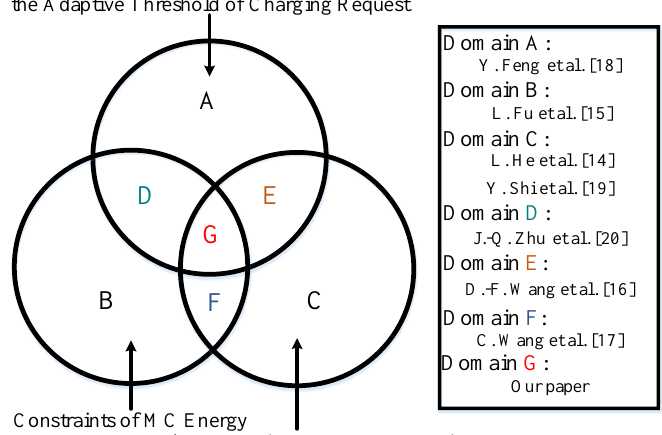
Figure 1. Summary of related works.